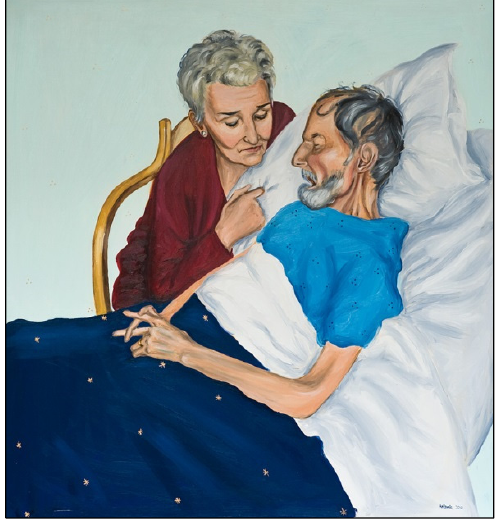
Figure 4. Peter and Anne